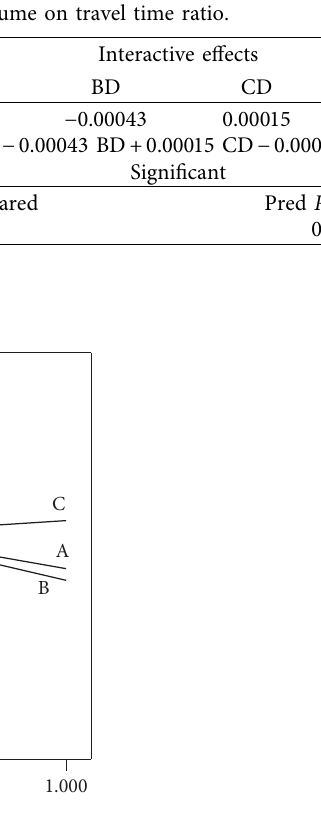
Figure 7: Trace plot for travel time